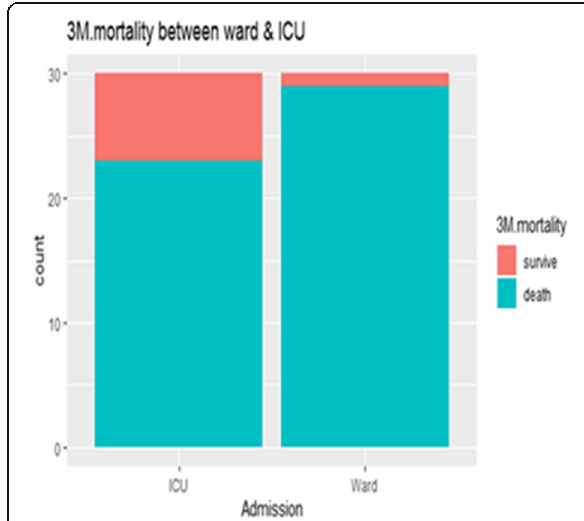
Fig. 6 3M. mortality between the ward and ICU groups. Figures 5 and 6 show that there is a non-significant difference between ward and ICU regarding 1M. and 3M.